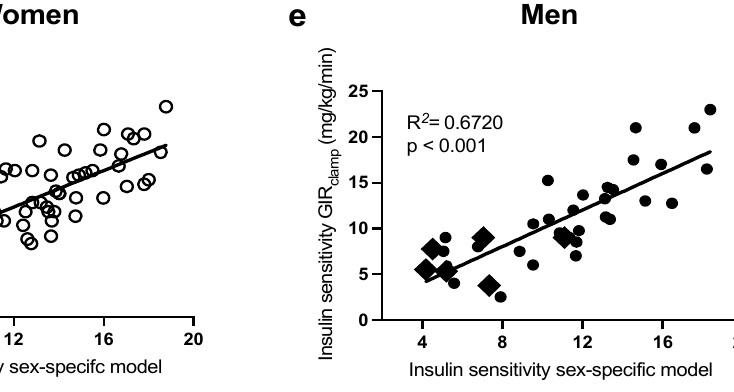
Figure 3. Pearson correlations between HIEG clamp measures of IS (GIR clamp ), with the sex-specific models for IS in women ( a ) and men ( e ), HOMA-IR and HOMA2-IR in women ( b ) and men ( f ), QUICKI in women ( c ) and men ( g ), and QUICKI-FFA in women ( d ) and men ( h ). Women are in open circles (N = 61, those with BMI > 40 kg/m 2 are in open diamonds) and men are in closed circles (N = 37, those with BMI > 40 kg/m 2 are in closed diamonds). 2.3. Bland–Altman Plots to Assess the Agreement with the Botnia-Clamp Data Bland–Altman plots were used to investigate the agreement of the sex-specific models of ISec, C-peptide secretion, and IS with their corresponding measures of the Botnia-clamp. In women, only 1–3 observations out of the total 61 observations for GIIS IVGTT (Figure 4a,c),